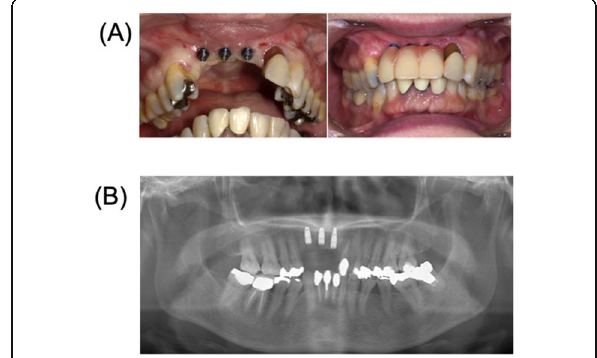
Fig. 6 Placement of three dental implants and provisional prosthesis. a Intraoral findings. b Postoperative